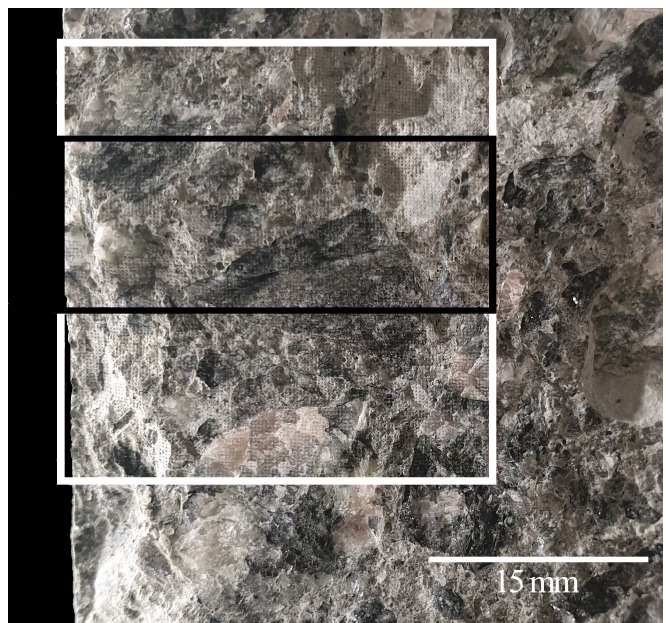
Figure 10. A specimen from an existing structure exposed to chloride, side of impact for the undam- aged surface from the left-hand side and in addition through the depth of the concrete cover. The white rectangular shows the area that scanned by LIBS. The black rectangle marks the area for the determination of the chloride profile.